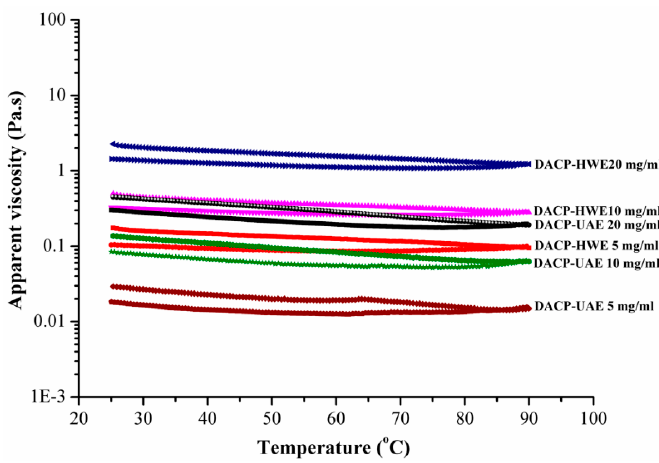
Figure 6. Steady shear flow curves of DACP-HWE and DACP-UAE solutions with different concentrations (5, 10, 20 mg/mL) as a function of temperature (25–90 ° C).